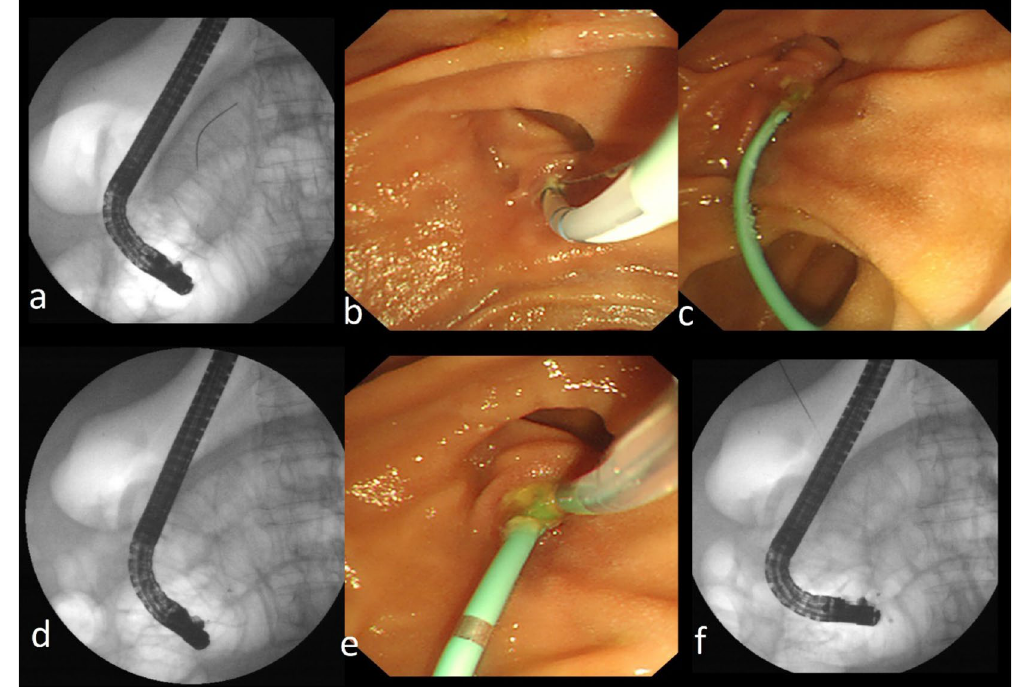
Figure 2. Transpancreatic sphincterotomy technique. ( a ) Fluoroscopy image showed the guidewire inserted in the pancreatic duct. ( b ) The septum was cut with a sphincterotome from the pancreatic duct towards the bile duct axis. ( c ) The placement of pancreatic duct stent. ( d ) After a stent was placed in the pancreatic duct. ( e ) Cannulation toward the bile duct was performed. ( f ) The biliary cannulation was successfully